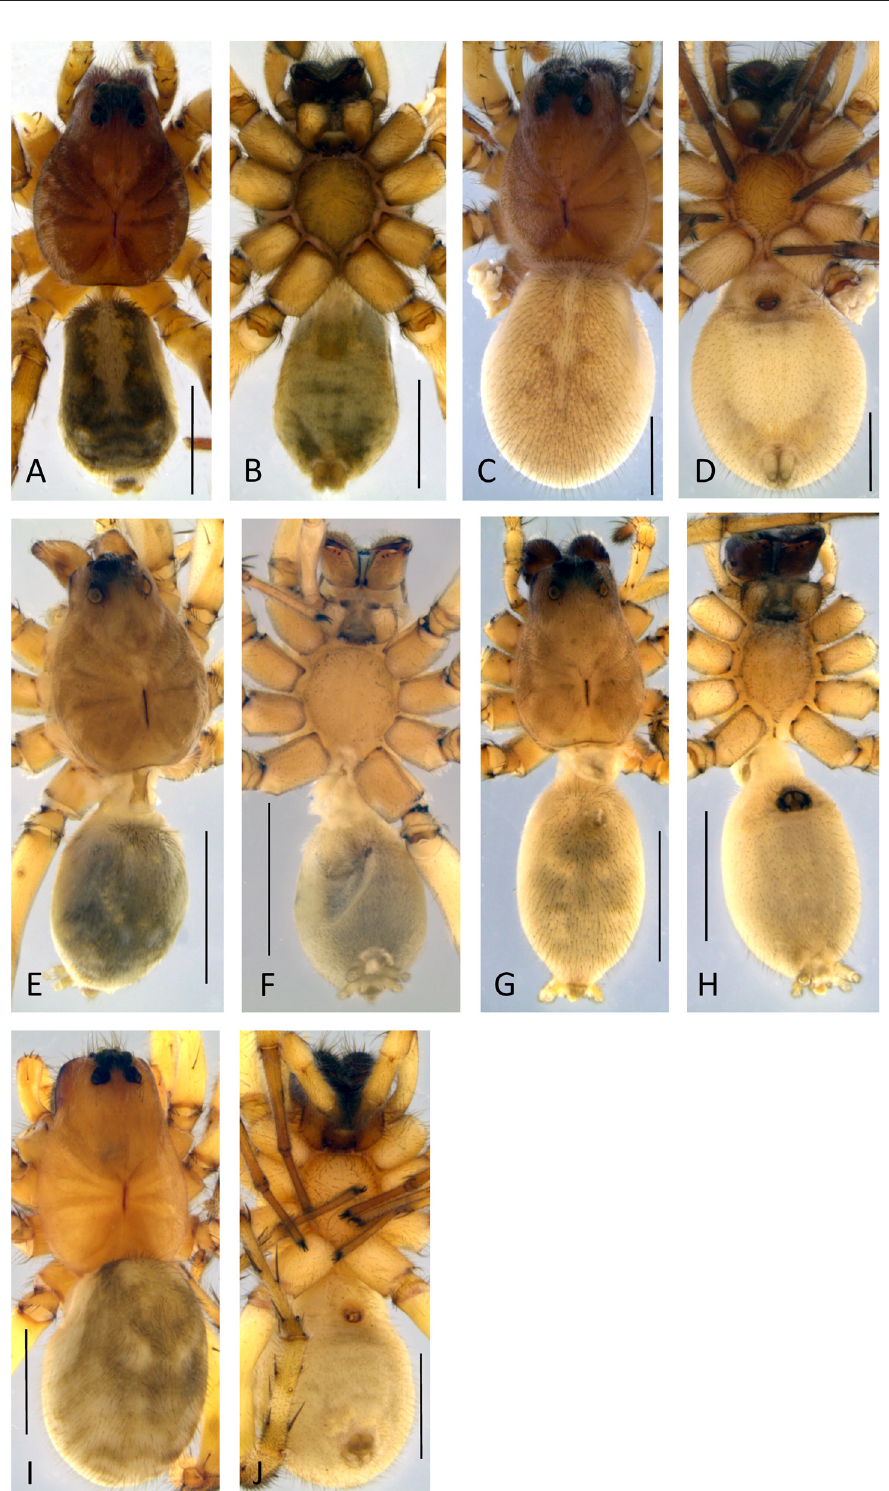
Fig. 5. Tetralycosa Roewer, 1960, microscopic photographs showing dorsal and ventral views. A–B . T. oraria (L. Koch, 1876), ♂ (WAM T93541). C–D . T. oraria (L. Koch, 1876), ♀ (WAM T93944). E–F . T. arabanae (Framenau, Gotch & Austin, 2006), ♂ (WAM T47298). G–H . T. arabanae (Framenau, Gotch & Austin, 2006), ♀ (WAM T47298). I–J . T. caudex sp. nov. , ♀ (WAM T55576). Scale bars: A–J =